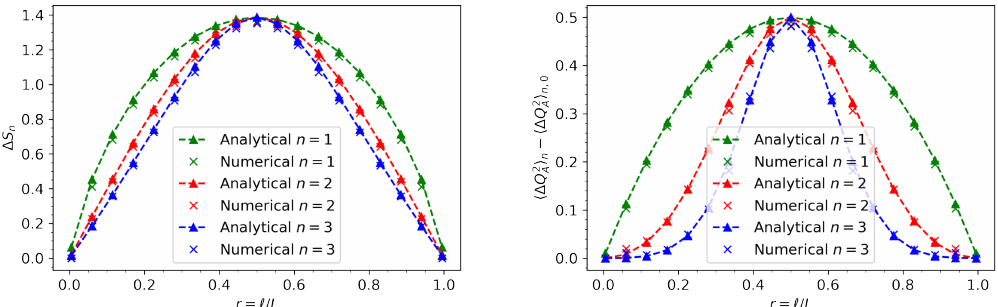
= π/ 2 , L = 200 and different values of n for F